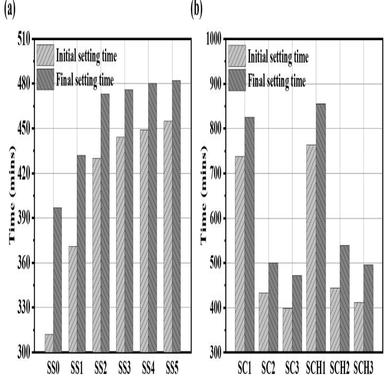
Initial and final setting time test results: (a) Setting time of mortar with different SS content; (b) Setting time of mortar with different activators.